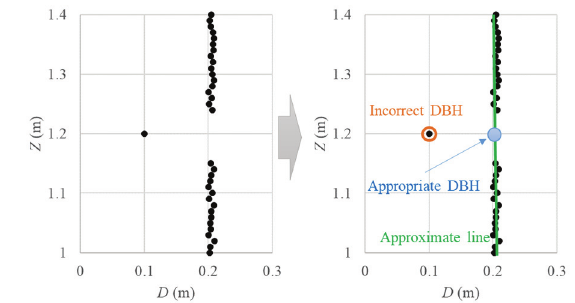
Figure 9 . Difference the DBH by estimation method